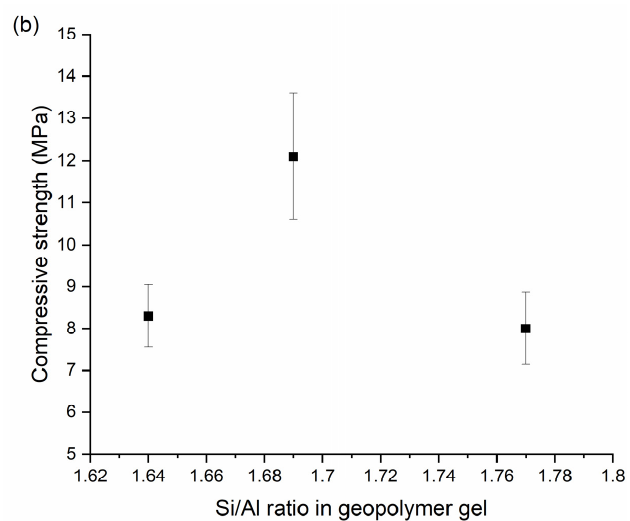
Figure 4. Compressive strength versus ( a ) degree of reaction and ( b ) Si / Al of geopolymer gel for non-Ca mixtures.